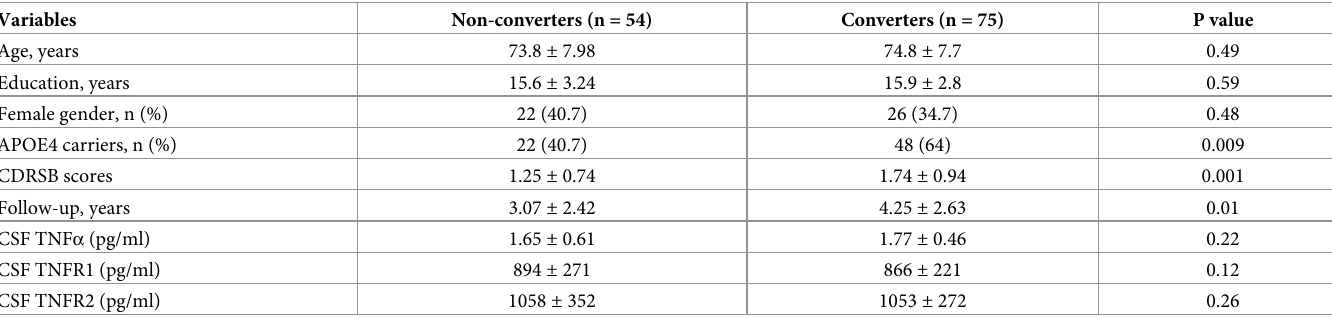
Table 1. Demographic and clinical information between non-converters and